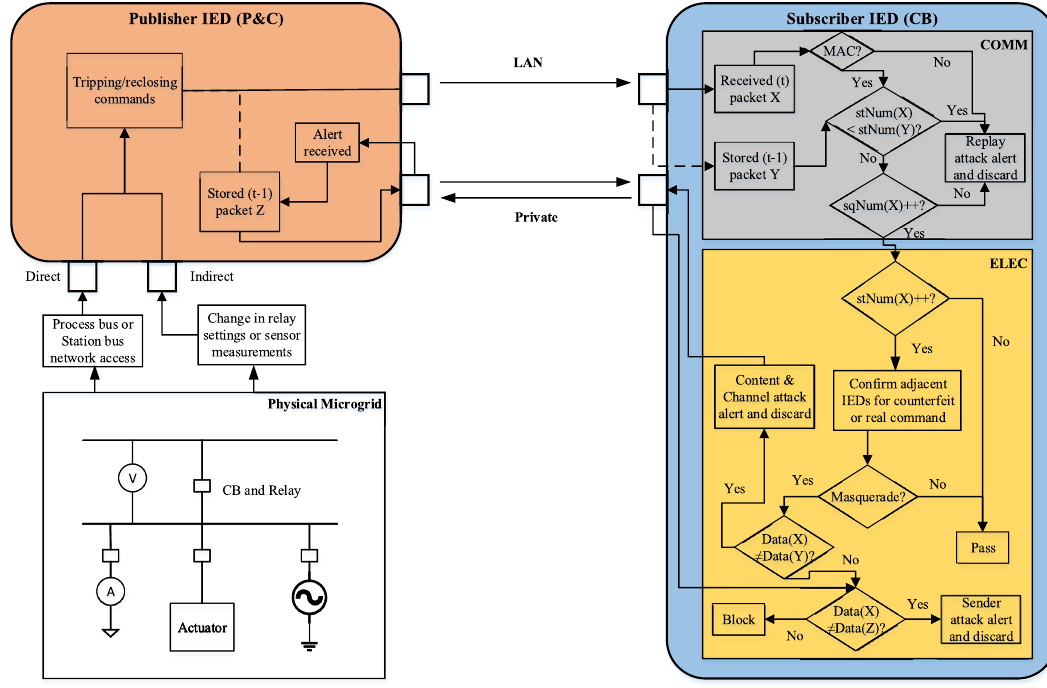
Figure 11. Functional diagram of novel sequence content resolver for GOOSE communication